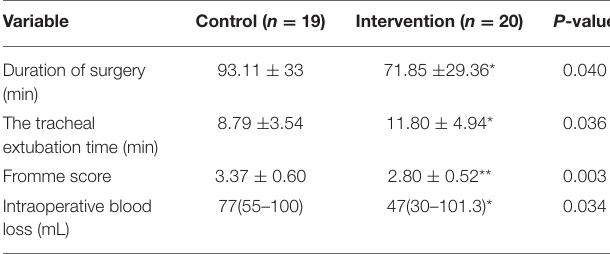
TABLE 1 | Demographic and preoperative characteristics. TABLE 2 | Clinical characteristics of control and intervention